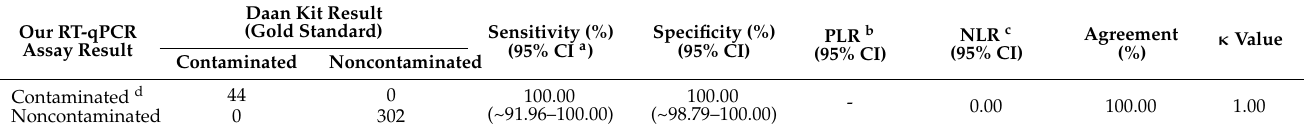
Table 4. SARS-CoV-2 vaccine contamination diagnostic performance of our RT-qPCR assay for 346 clinical samples.